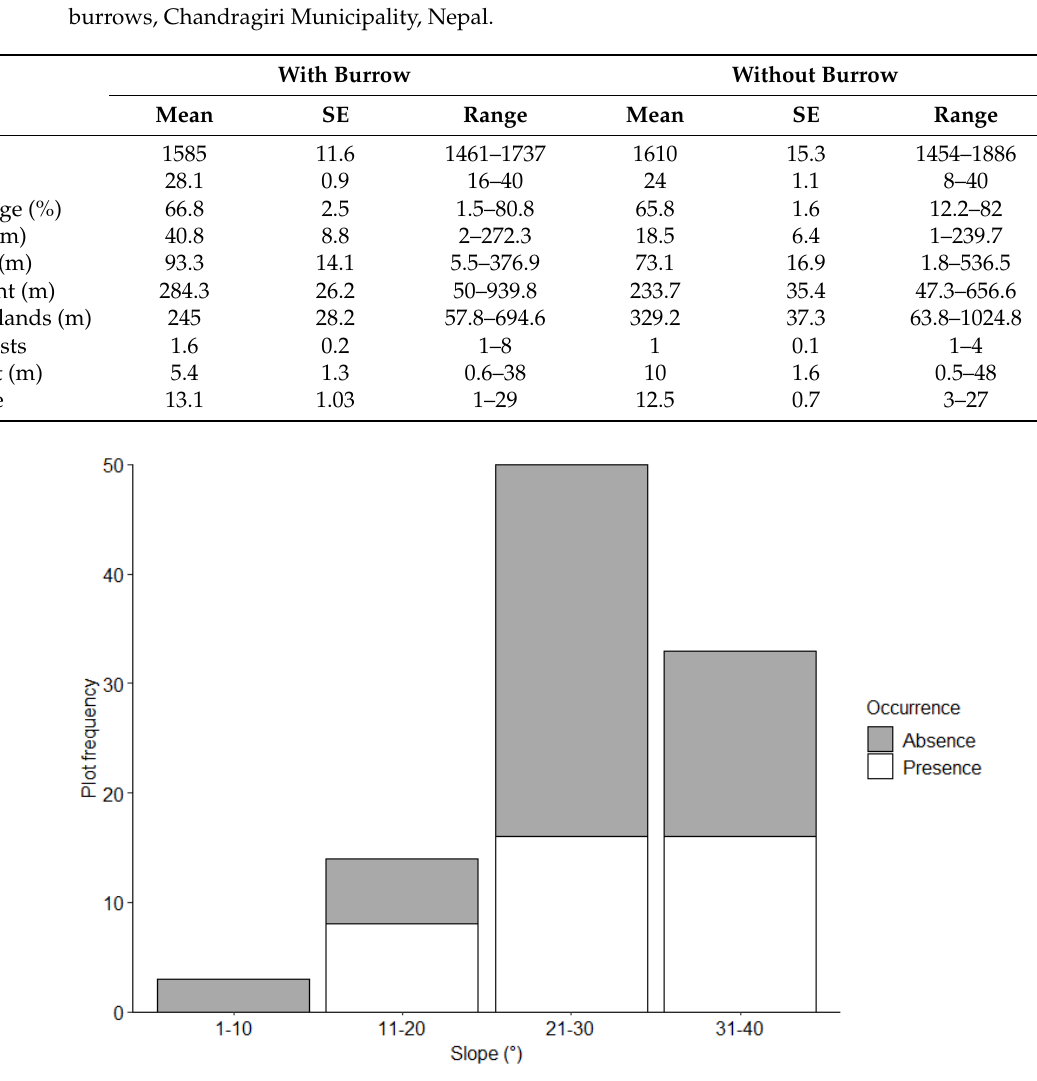
Table 1. Habitat variables for sites with ( n = 38) and without ( n = 62) Chinese pangolin foraging